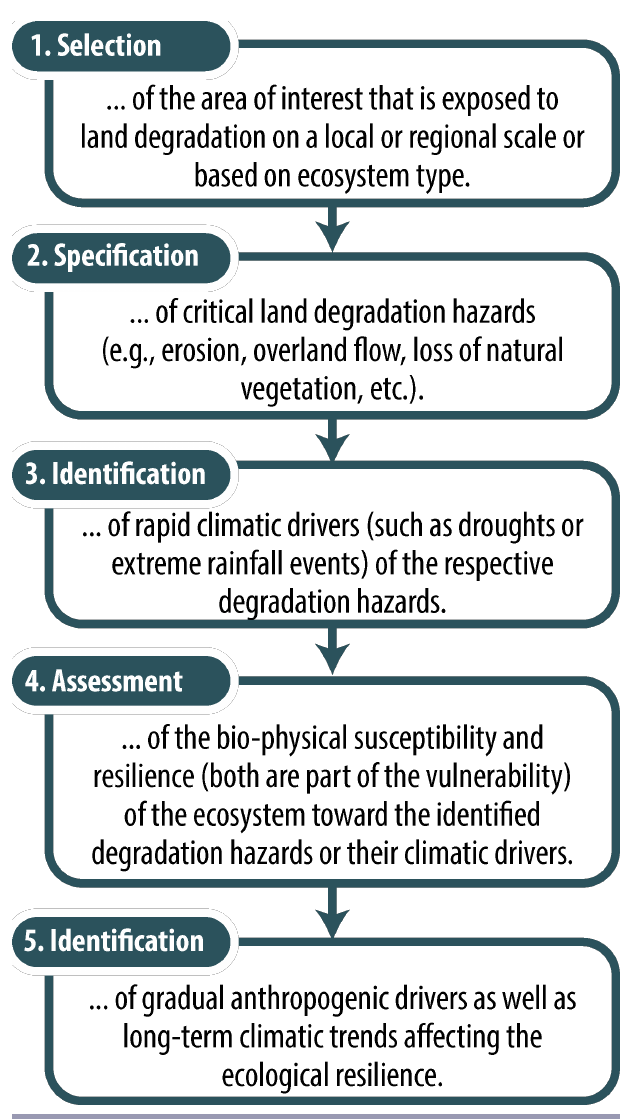
Fig. 1. Suggested steps for a land degradation risk analysis at ecosystem level, integrating the risk framework of the United Nations Office for Disaster Risk Reduction and the concept of ecological resilience.